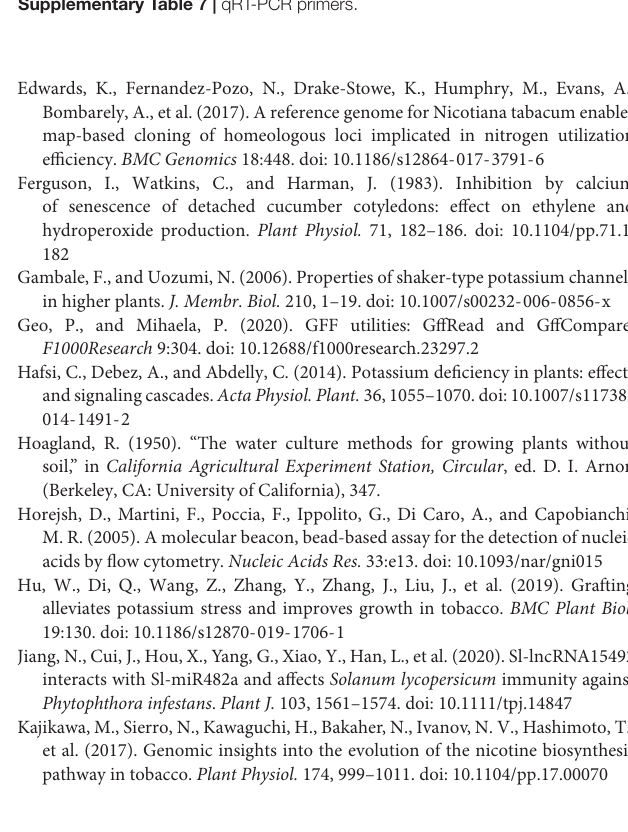
Supplementary Table 2 | The summary of potential LncRNAs. Supplementary Table 3 | The differentially expressed LncRNAs. Supplementary Table 4 | Modules of co-expression network and their correlation with low K treatments. Supplementary Table 5 | Candidate hub LncRNAs in nine K + -responsive modules. Supplementary Table 6 | GO enrichment result associated with tissues x treatments. Supplementary Table 7 | qRT-PCR